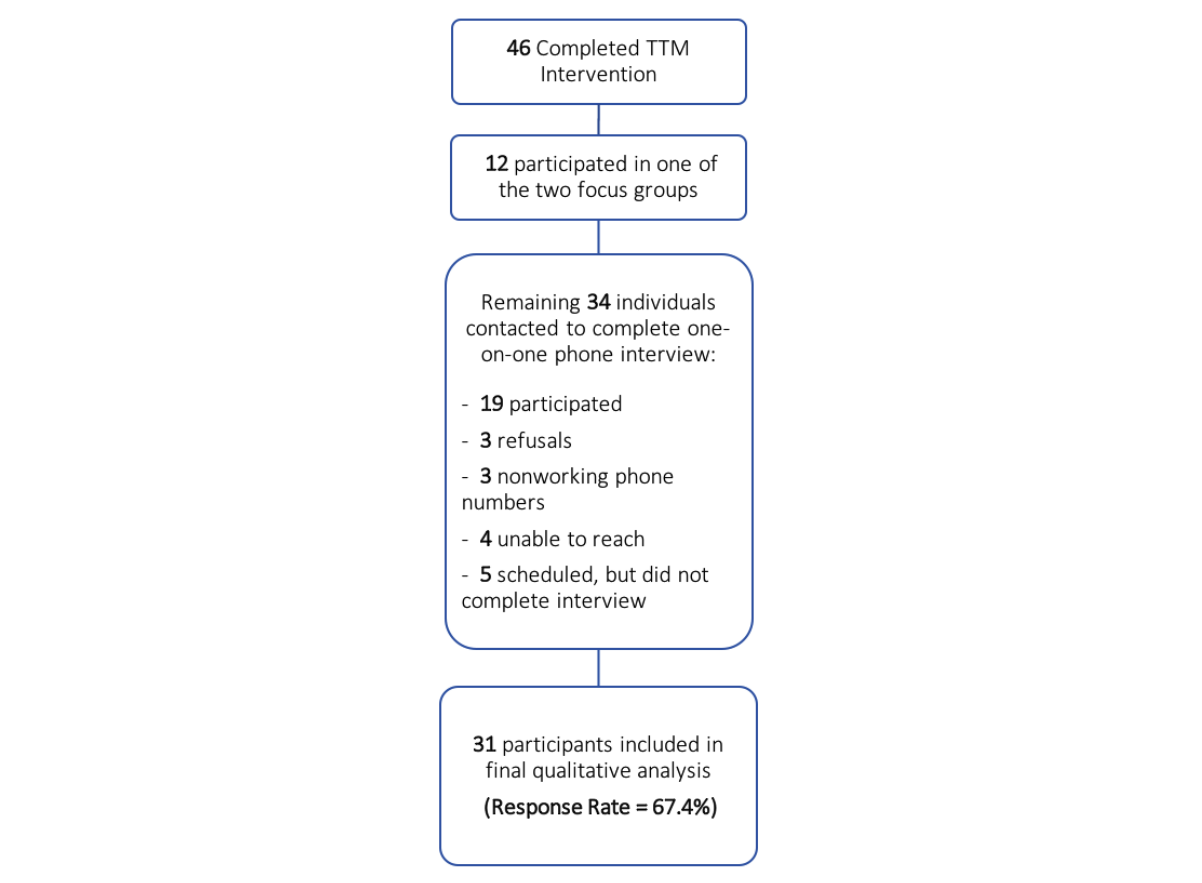
Figure 1. Recruitment of participants from Text to Move (TTM) intervention